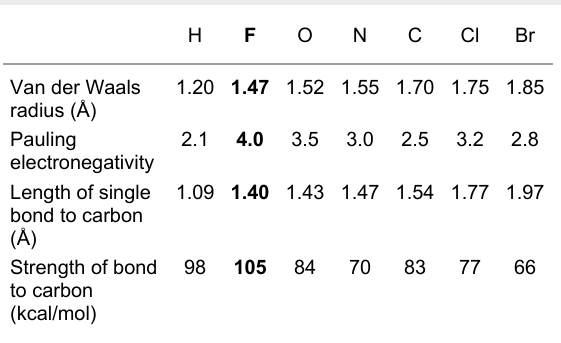
Table 1: Properties of some common elements and of their bonds to carbon [2,3]. H F O N C Cl Br